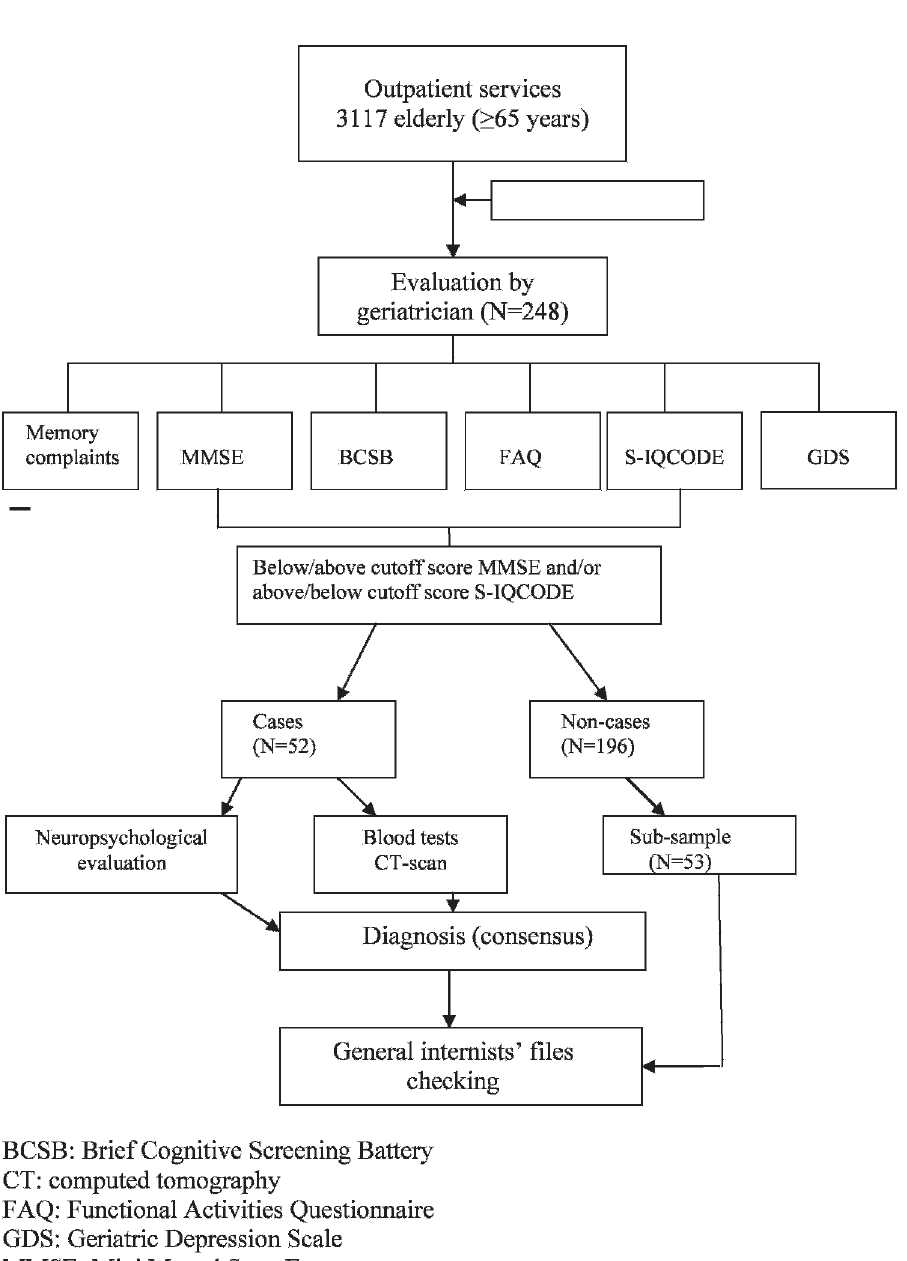
Figure 1 - Flow diagram from outpatient services to study completion. BCSB: Brief Cognitive Screening Battery. CT: Computed Tomography. FAQ: Functional Activities Questionnaire. GDS: Geriatric Depression Scale. MMSE: Mini-Mental State Exam. Short- IQCODE: Informant Questionnaire on Cognitive Decline in the Elderly